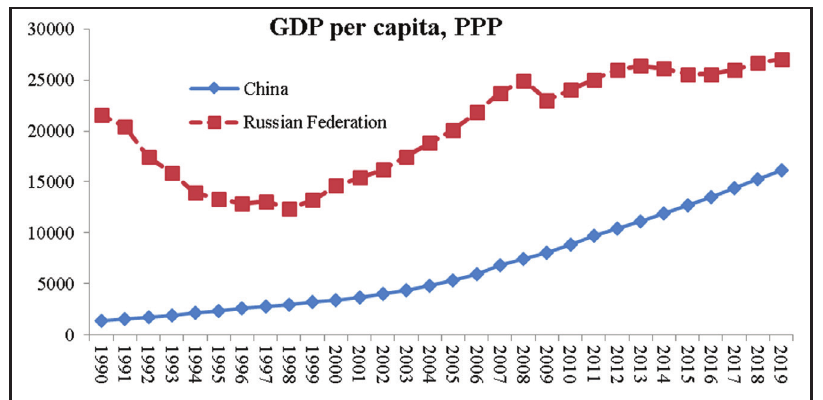
Figure 2 GDP per capita in China and Russia in constant Purchasing Power Parity (PPP).